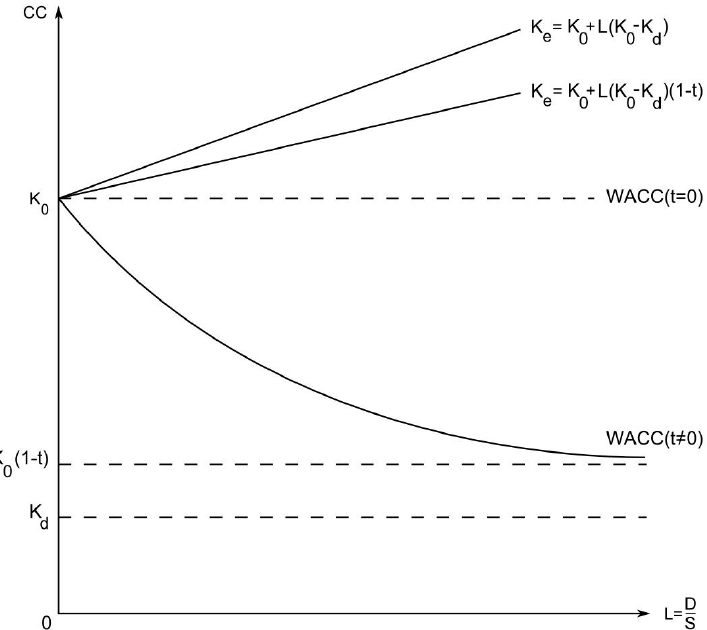
Figure 3. Impact of leverage level on equity capital cost k e , and WACC within the Modigliani–Miller theory without taxes ( t = 0) and with taxes ( t (cid:54) = 0 ).